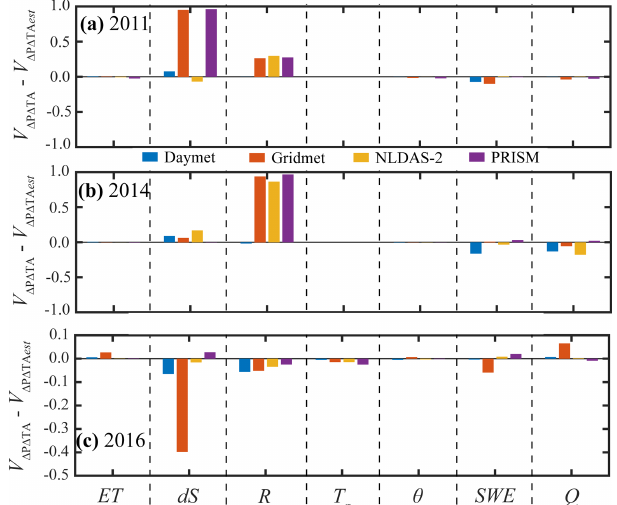
Figure 14. The difference between the predicted and actual changes from combined variability in P and T air for WY2011 (a) , WY2014 (b) , and WY2016 (c)